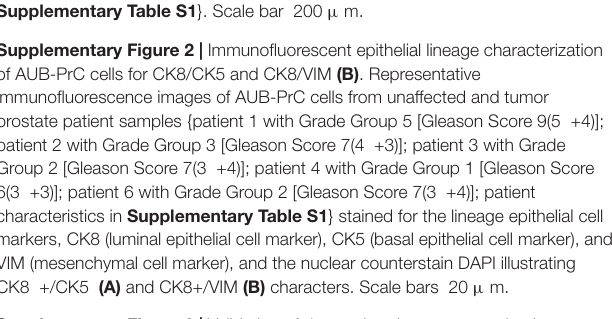
Supplementary Figure 3 | Validation of dysregulated gene expression in AUB-PrC cells relative to their tissue counterparts. (A) Upregulation of CK8